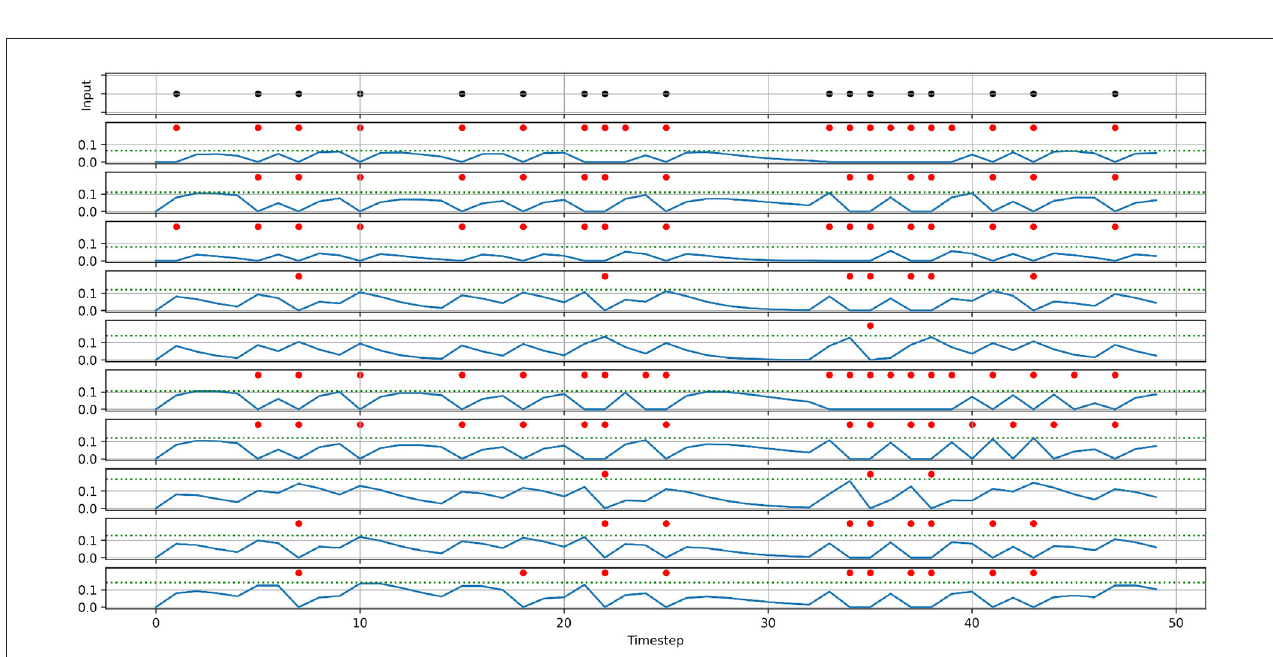
FIGURE2 Demonstration of the effects of randomizing membrane parameters. An input spike train (top) is fed into ten neurons with the same synaptic weight. Instead of setting the membrane parameters’ values of all neurons to the same value, the values are drawn from a normal distribution with the means: µ α 0.5, µ β 0.5, µ threshold 0.1, and the standard deviation: σ 0.3 µ . The panels below the input spike train show the membrane potentials (solid blue = = = = lines), thresholds (dashed blue lines), and the spikes (red dots) of the ten neurons.